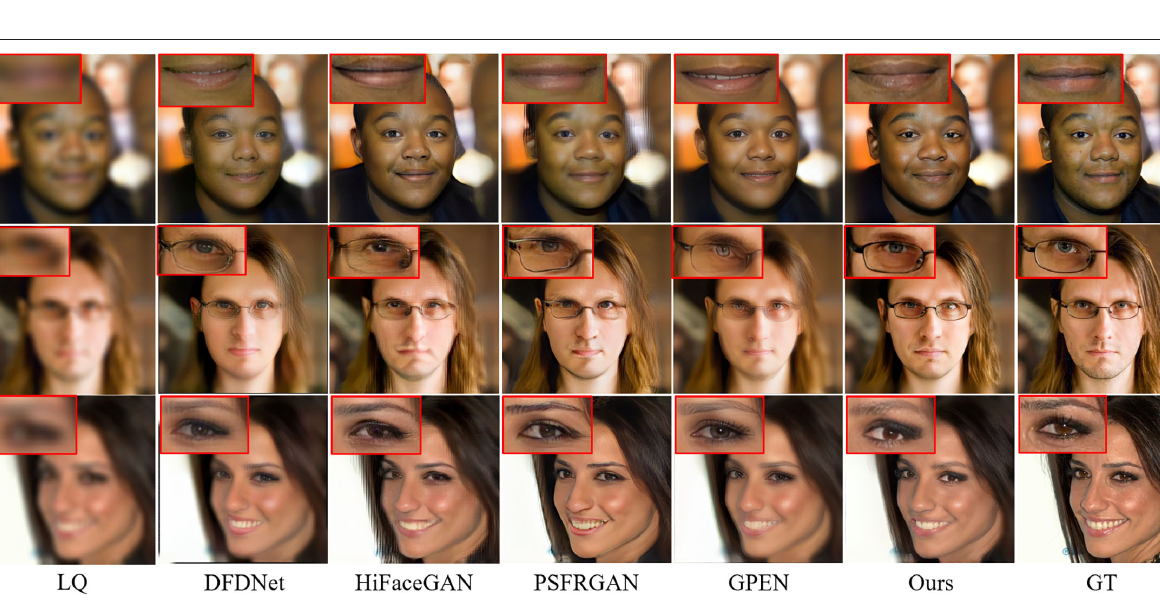
FIGURE 10 | Visual comparison for non-integer face SR (i.e.,